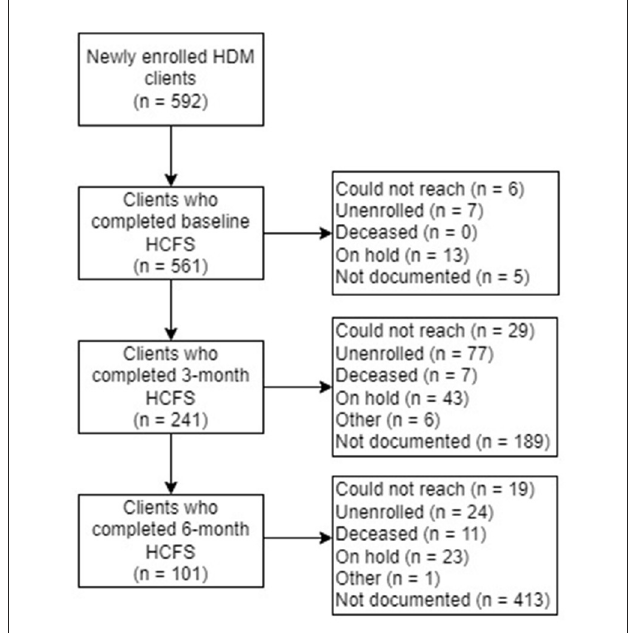
FIGURE4 Home-delivered meals (HDM) clients who completed the Home Care Frailty Scale (HCFS) at baseline, 3-months, and